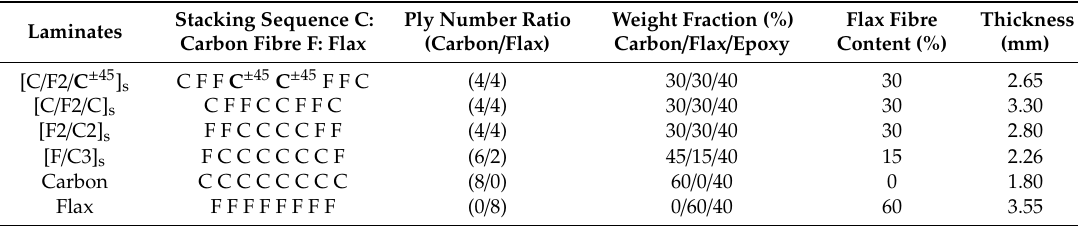
Table 1. Di ff erent lay-ups of hybrid flax / carbon fibre